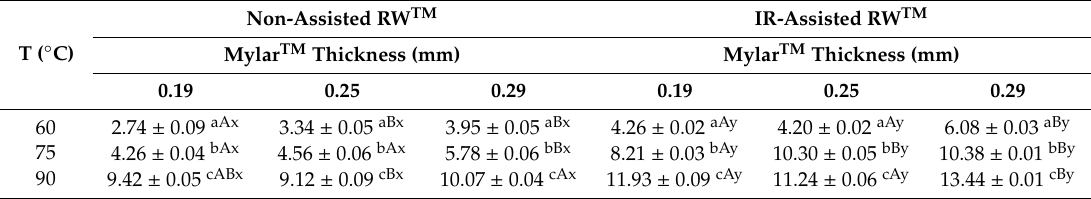
Table 2. Moisture e ff ective di ff usivities ( D e ff × 10 − 10 m 2 / s) of dried Physalis pur é e subjected to di ff erent RW ™ drying